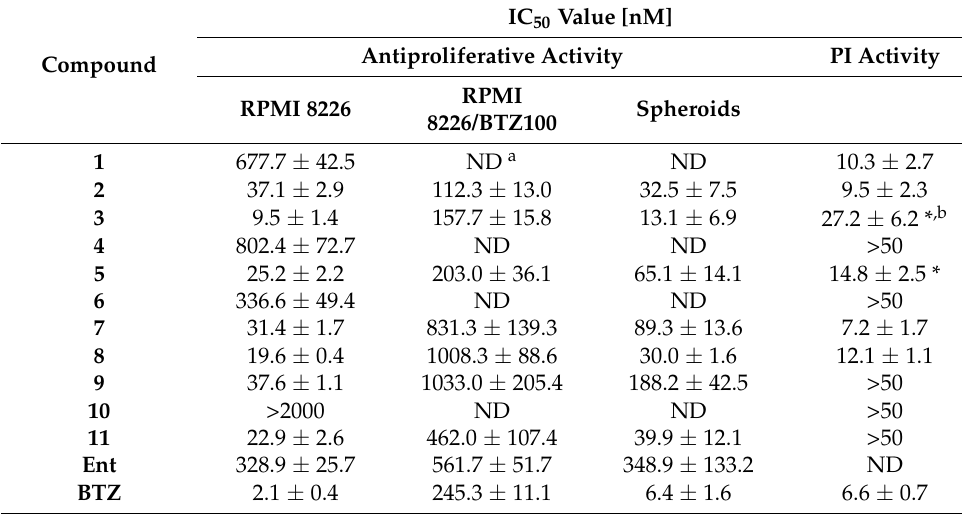
Table 1. Activity of compounds 1 – 11 in various MM models (IC 50 values ± SD, n = 3). IC 50 Value [nM] Antiproliferative Activity PI Activity Compound RPMI